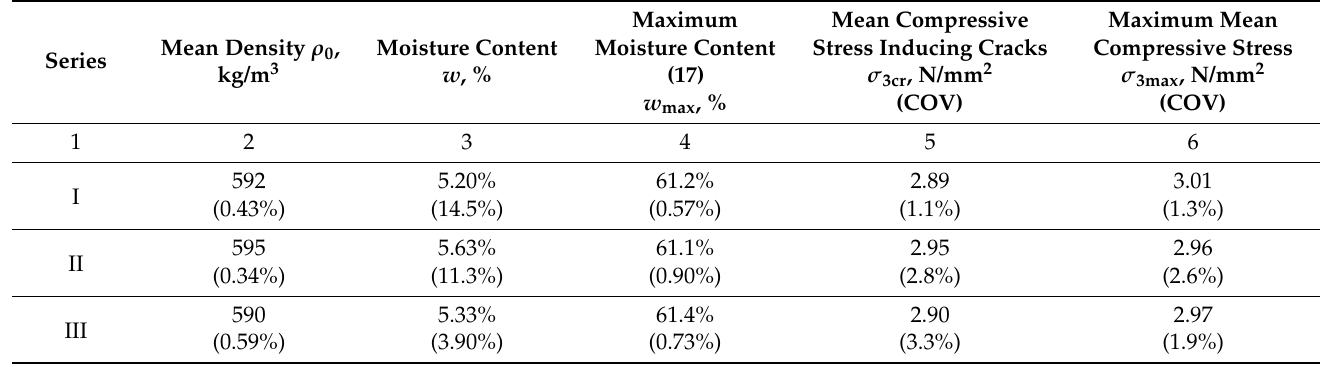
Table 4. Summary of mean results from the tests on the models.